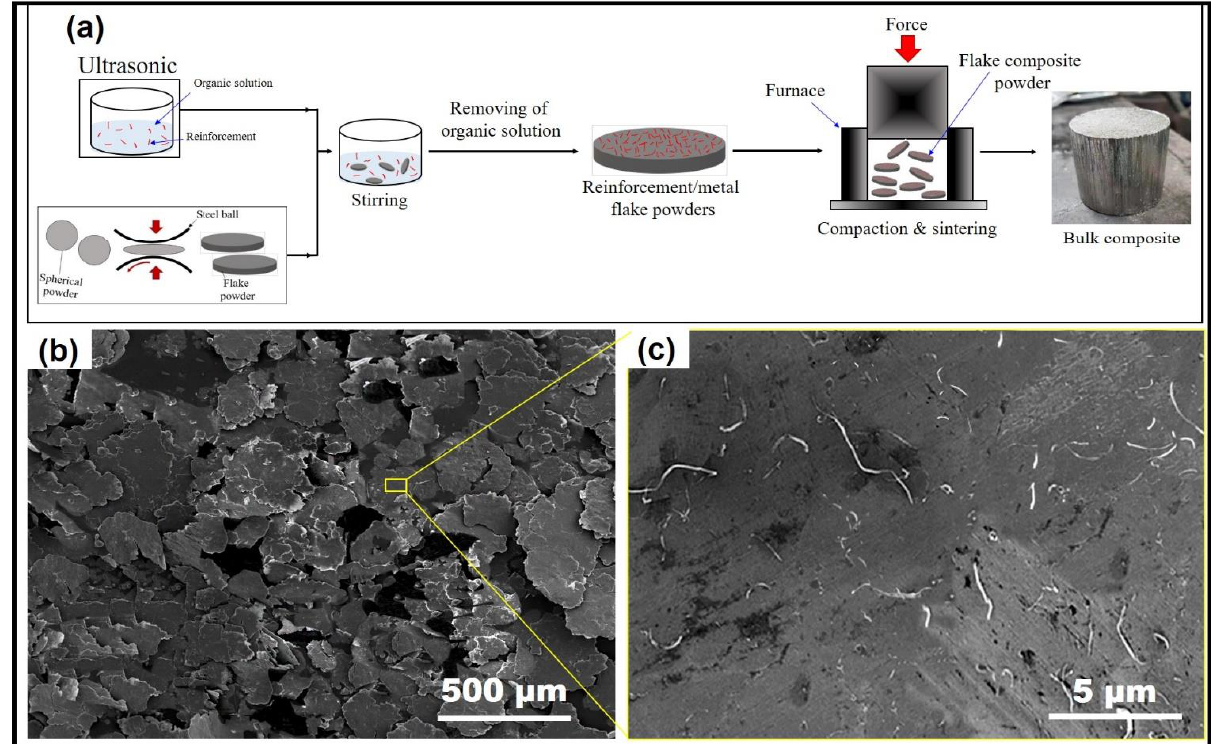
Figure 2. ( a ) Schematic of slurry-based dispersion process, ( b , c ) SEM images of CNT/Al flakes under FPM-SB route.